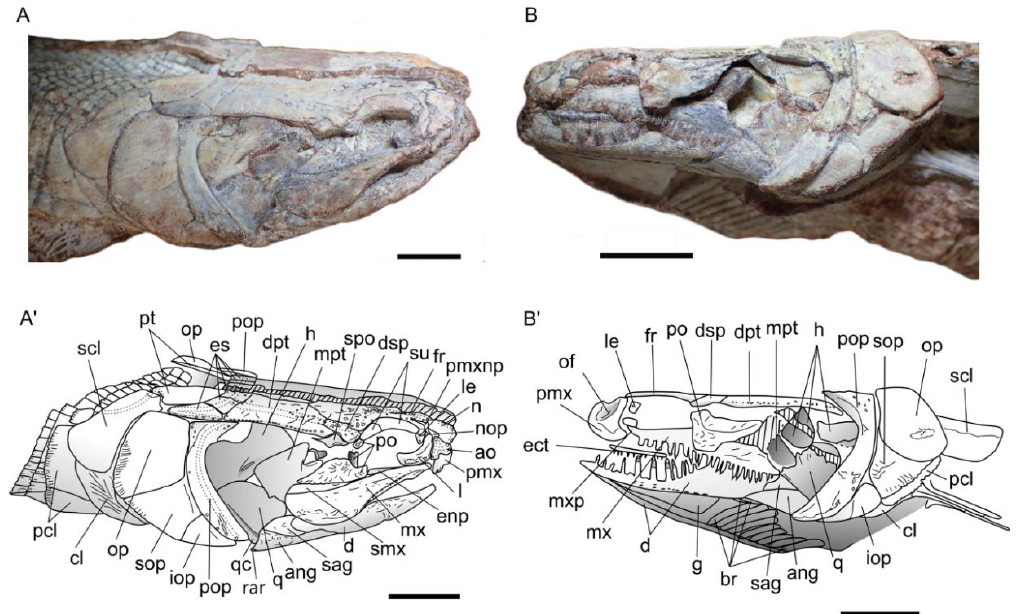
Figure 4. Khoratamia phattharajani gen. et sp. nov., holotype NRRU-F01020023, photograph of the skull in right lateral view: ( A ) interpretative drawing ( A’ ) and left lateral view ( B ) line drawing ( B’ ). Scales bar: 1 cm.